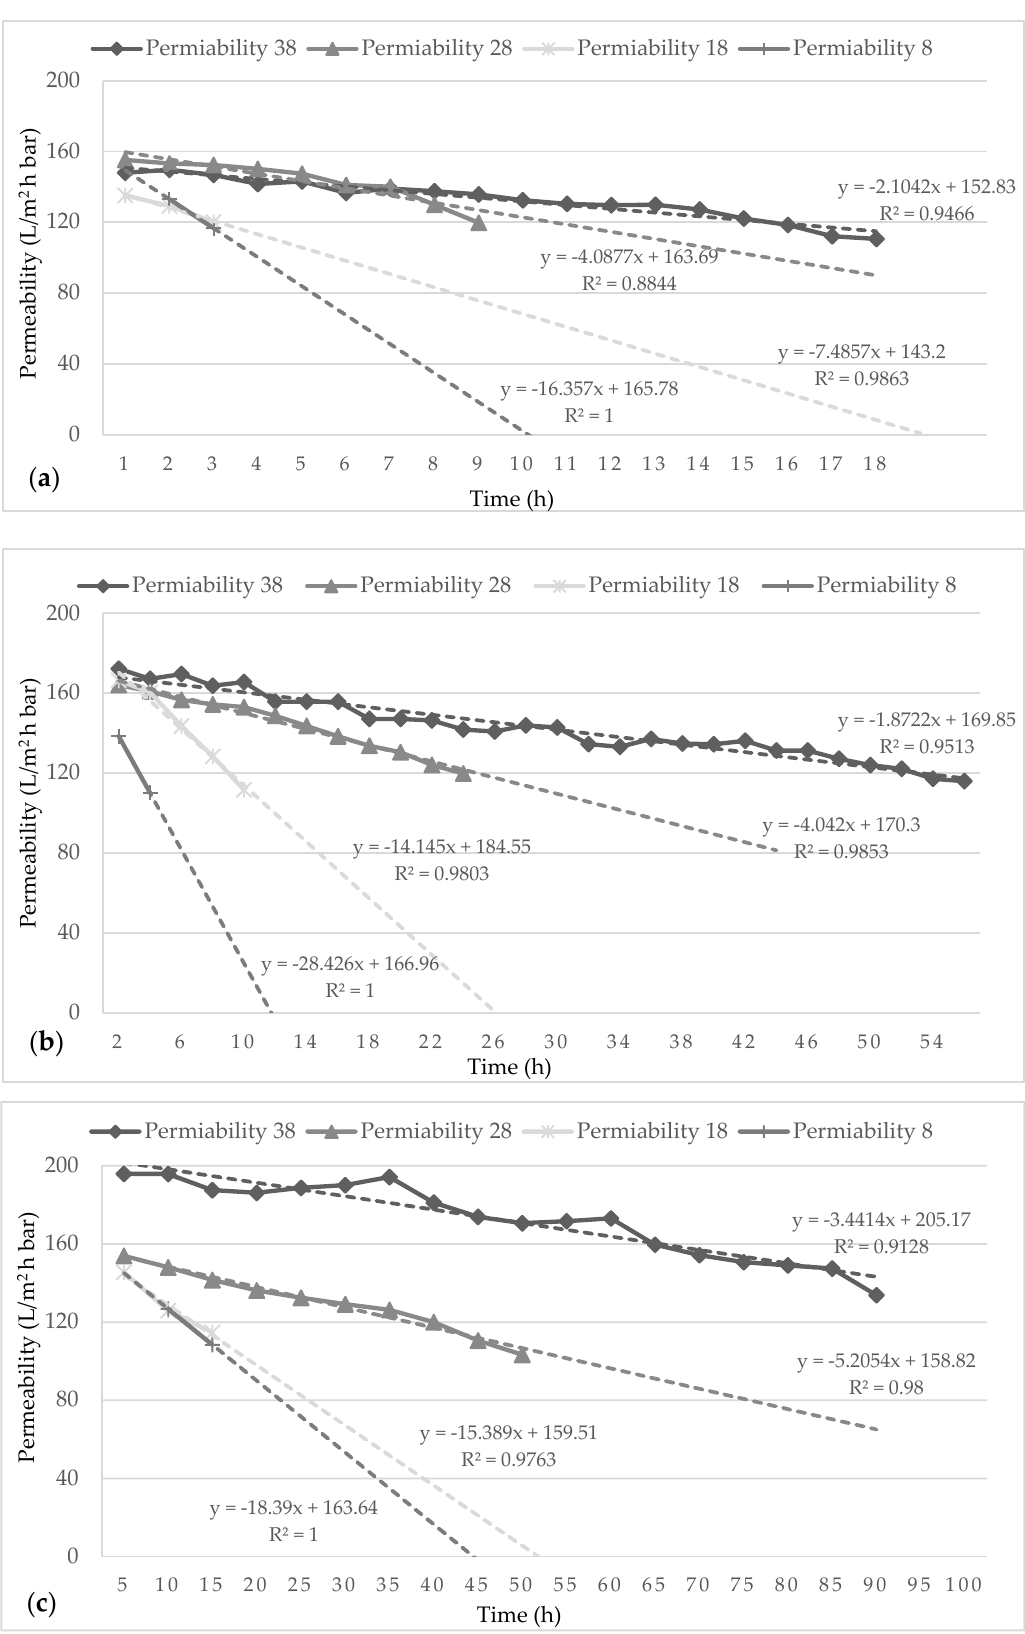
Figure 5. Mean membrane permeability with time for BW duration of ( a ) 1 min, ( b ) 3 min and ( ° ) 8